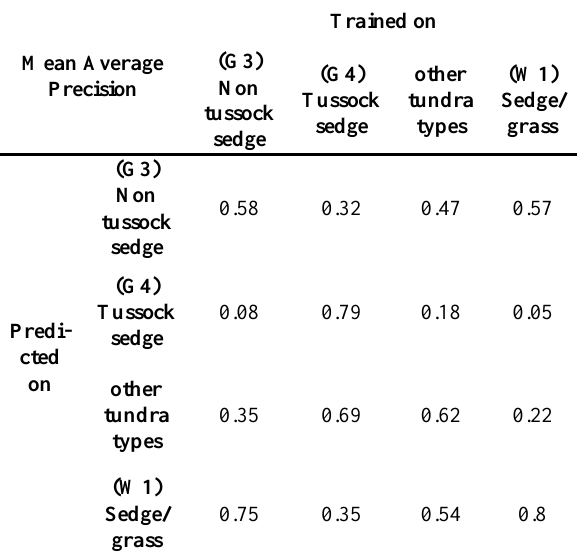
Table 2. Mean average precision values for models trained on different tundra